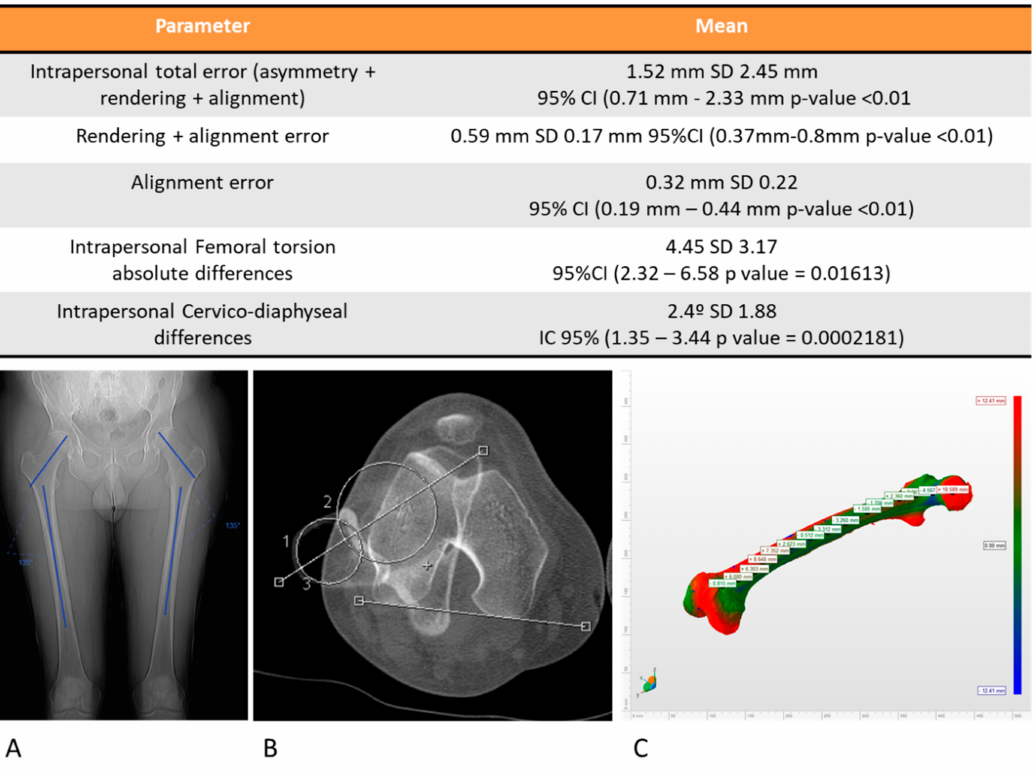
Figure 4. Table of the results. ( A ) Measurement of the intrapersonal cervico-diaphyseal angle asymmetry. ( B ) Measurement of the femoral torsion using Murphy’s method. ( C ) Representation of the measurement of the intrapersonal 3D